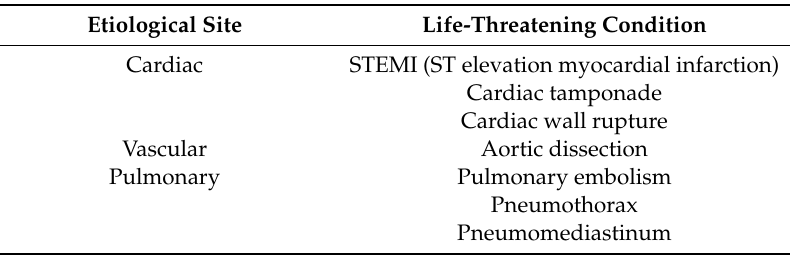
Table 2. Life-threatening conditions of chest